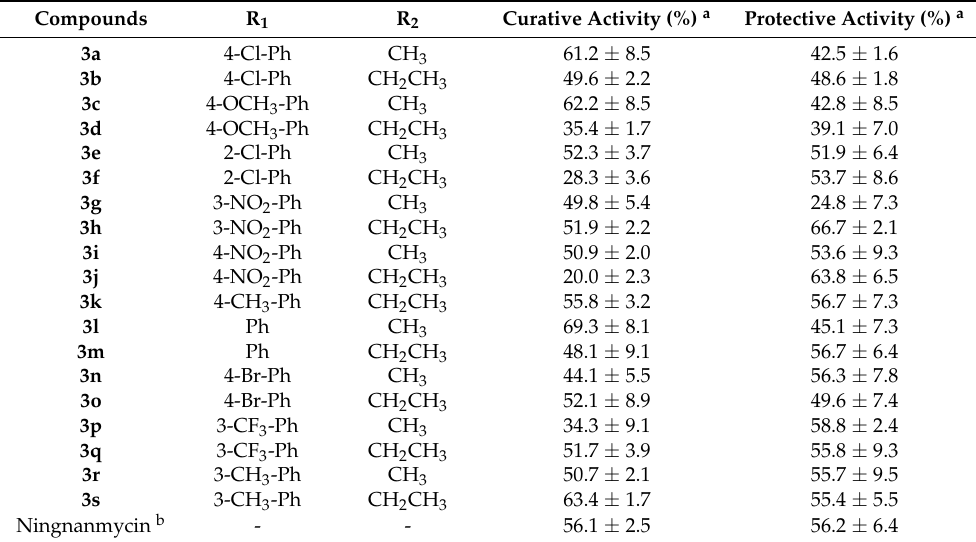
Table 3. Antiviral activities of the test compounds against tobacco mosaic virus (TMV) in vivo at 500 µ